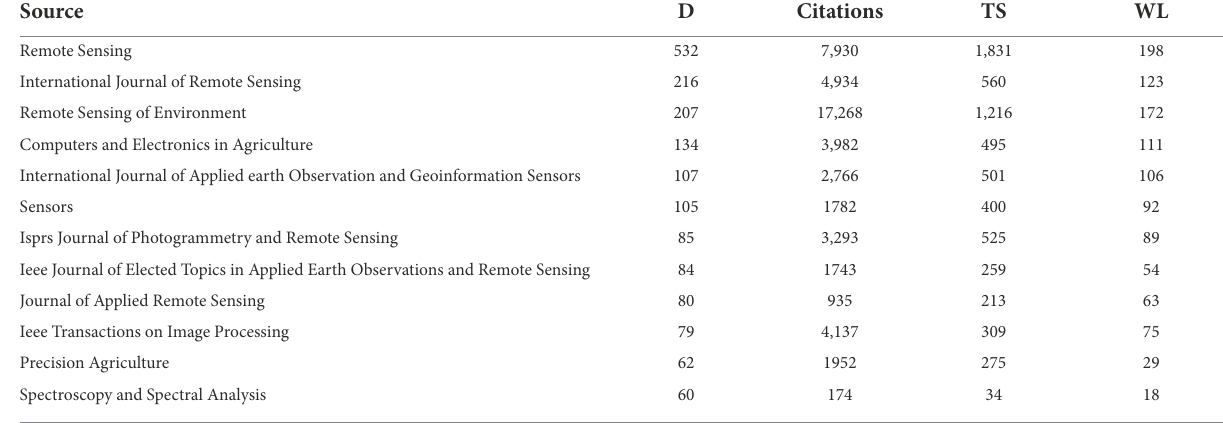
TABLE 2 Top 12 journals for local citation ranking of agricultural multispectral studies in 2002–2021.